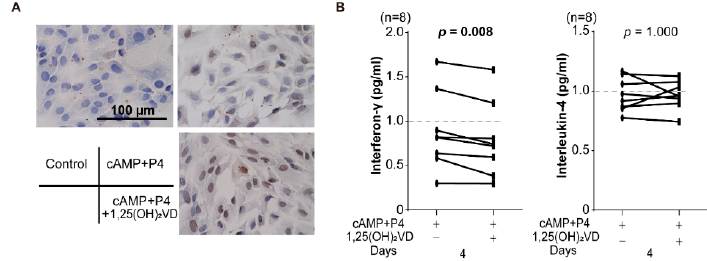
Figure 3. Role of vitamin D in decidualization of human endometrial stromal cell. ( A